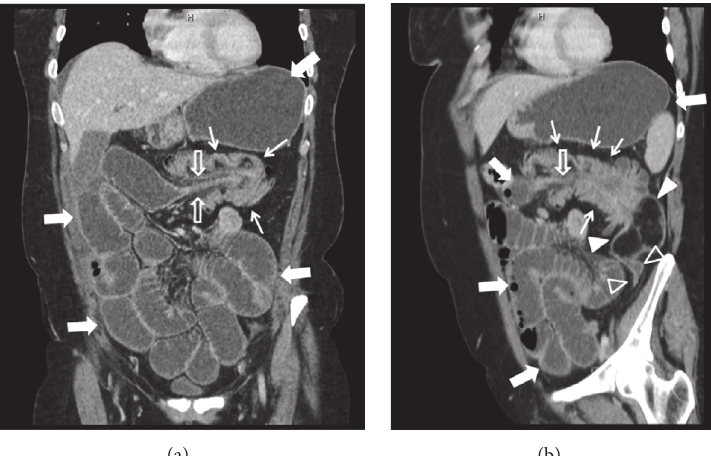
Figure 2: Contrast-enhanced CT, portal venous phase, multiplanar reconstructions (coronal plane, (a), and paracoronal plane, (b)). The same features described in (a) can be appreciated: the dilated stomach and small bowel loops (full arrows), the right colon, intussusceptum (empty arrows), the left colon, intussuscipiens (thin arrows), the colonic lipoma (full arrowheads), and the collapsed left colon distal to the lipoma (empty arrowheads).